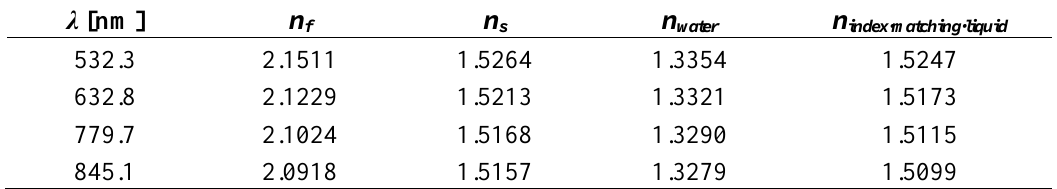
Table 1. Refractive Indices of the Sensor Materials at the Investigated